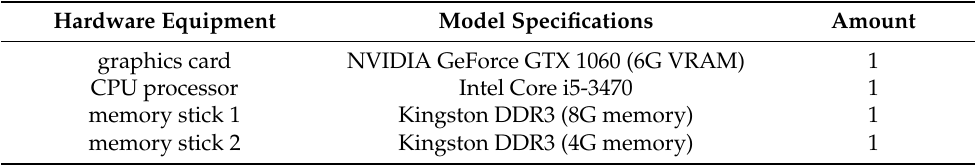
Table 1. Deep learning hardware platform